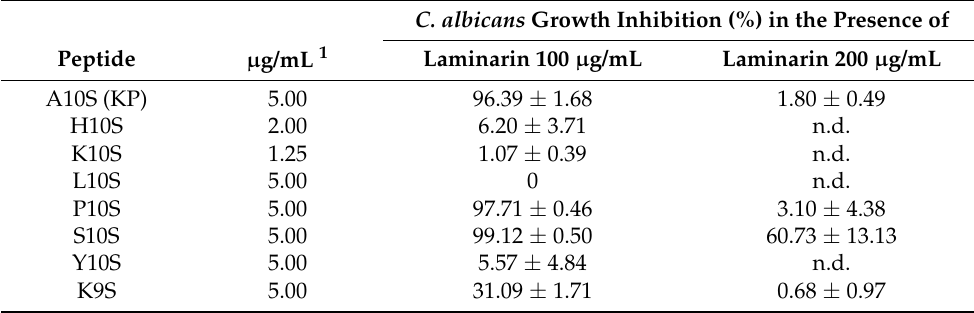
Table 2. Neutralization of in vitro candidacidal activity of KP and KP-derivatives by laminarin. C. albicans Growth Inhibition (%) in the Presence of Peptide µ g/mL 1